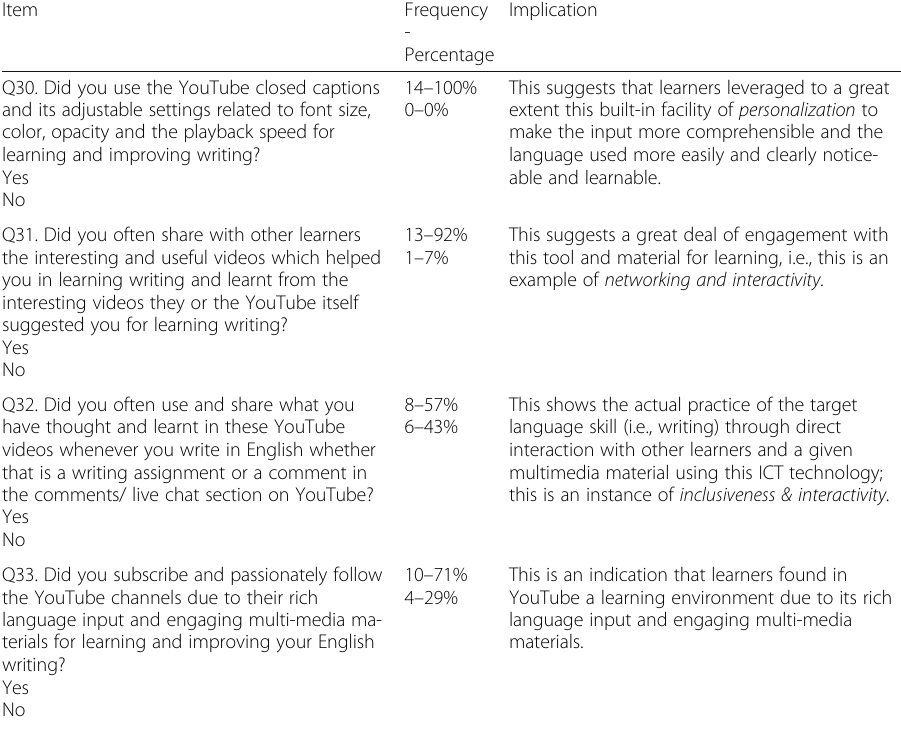
Table 8 Frequency Distribution of Items Responses from the questionnaire ( n = 14) Item Frequency